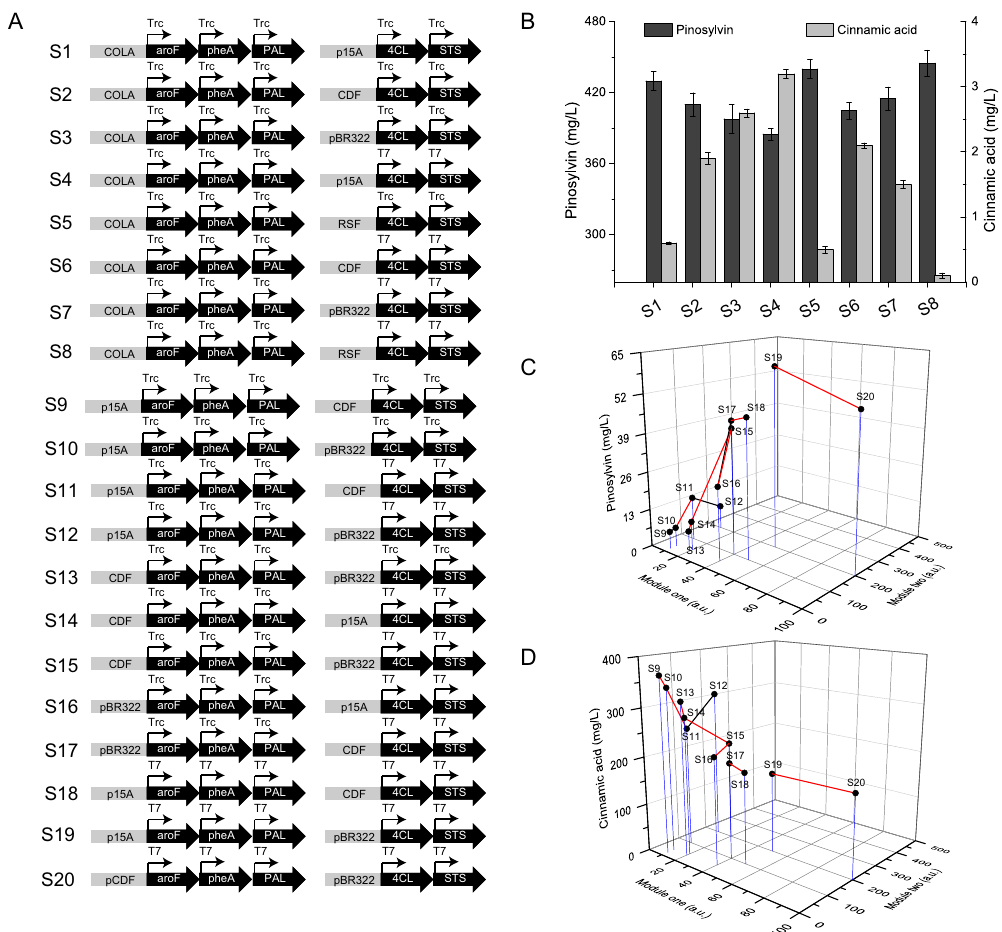
Figure 2. Rational modular design of the overall pathway to remove the pathway bottleneck. ( A ) A series of module one and two expression cassettes were designed at different expression levels. ( B ) The concentrations of pinosylvin were achieved by different expression cassettes (S1–S8). ( C ) Different pinosylvin concentrations were obtained by expression cassettes between S9–S20. ( D ) Different cinnamic acid concentrations were obtained by expression cassettes between S9–S20. COLA: origin of pCOLADuet-1; CDF: origin of pCDFDuet-1; pBR322: origin of pETDuet-1; p15A: origin of pACYCDuet-1; RSF: pRSFDuet-1; Trc: Trc promoter; T7: T7 promoter. S1–S20 demotes strains 1–20 constructed in the